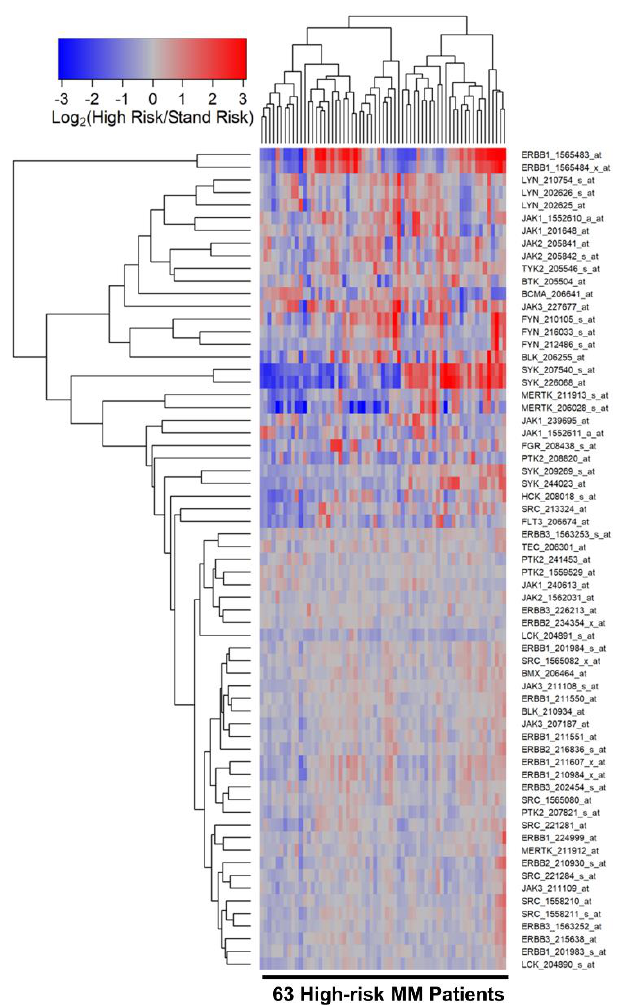
Figure 3. Gene Expression Levels for Tyrosine Kinases in Malignant Plasma Cells from High-Risk vs. Standard-Risk MM Patients. We examined the gene expression data in the archived MM dataset GSE19784. Patients were risk-categorized based on the patient-specific EMC-92/SKY-92 gene ex- pression signature values. The cluster figure displays the expression levels in malignant plasma cells from high-risk MM patients mean centered to the expression levels in malignant plasma cells from standard-risk MM patients for log 2 -transformed fold change values (blue represents underexpres- sion and red color represents overexpression in high-risk MM patients). The expression levels of co- regulated probesets for both probesets (rows) and patients (columns) are organized in the depicted dendrograms. The comparison of the log 2 -transformed RMA values for 219 standard-risk MM pa- tients with the log 2 -transformed RMA values for 63 high-risk MM patients showed 11 dysregulated probesets of which 5 were upregulated in the high-risk subset. JAK3_227677_at (Fold Change = 1.48; p -value = 1.4 × 10 −7 ), ERBB1_1565483_at (Fold Change = 1.44; p -value = 9 × 10 −7 ) and ERBB1_1565484_x_at (Fold Change = 1.27; p -value = 1.2 × 10 −3 ) were the most significantly upregu- lated probesets. Significant p -values were defined as p < 0.01 for FDR < 0.01 (Table S5). 3.3. Overexpression of EGFR/ERBB1 in MM Cells is Associated with Augmented Expression of Transcription Factors Binding to Multiple ERBB1 Gene Promoter Sites The transcription of the EGFR/ERBB1 gene is positively regulated by several DNA binding proteins/transcription factors, including ETF [34 – 36], SP-1 [37 – 41], TCF [42,43], HOXB5 [44,45], RPF-1 [46] and AP-1 [33,47 – 49]. In an effort to gain insights into the mech- anism of the observed transcript-level upregulation of the EGFR/ERB1 gene in MM sam- ples, we set out to correlate the mRNA levels for EGFR/ERBB1 with the mRNA levels for DNA binding proteins/transcription factors capable of enhancing EGFR/ERBB1